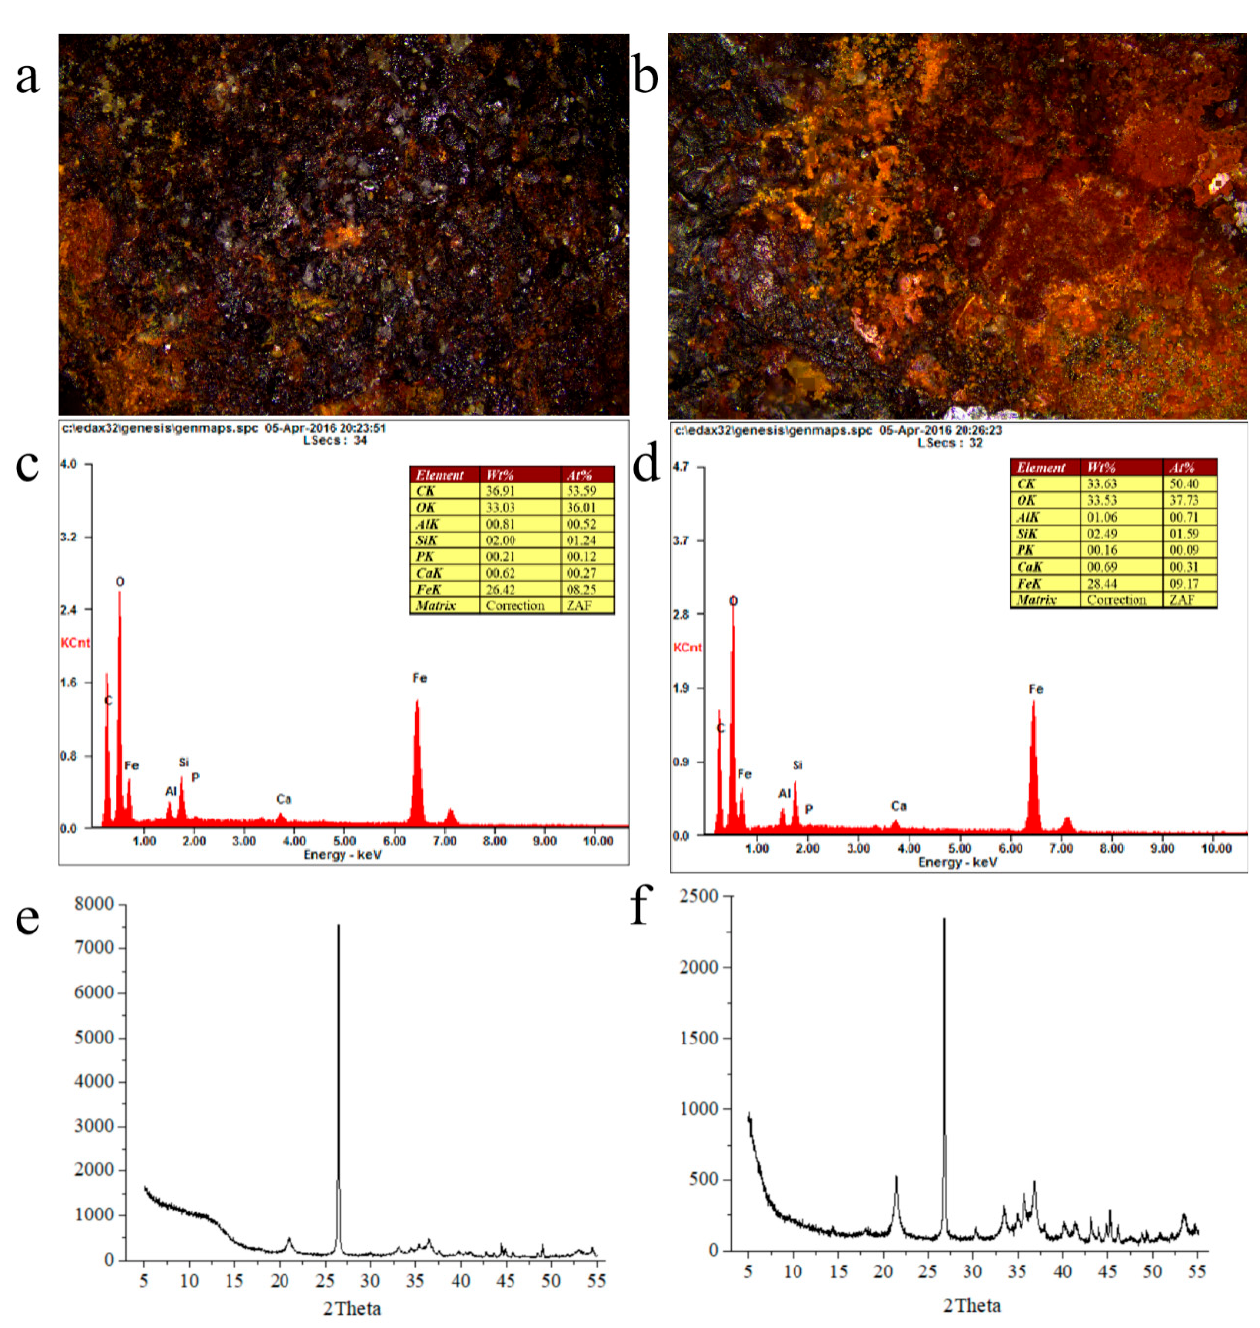
Figure 4. Micromorphology and elemental compositions of the rust samples. Polarizing microscope ( a , b ), EDS ( c , d ) and XRD ( e , f ).